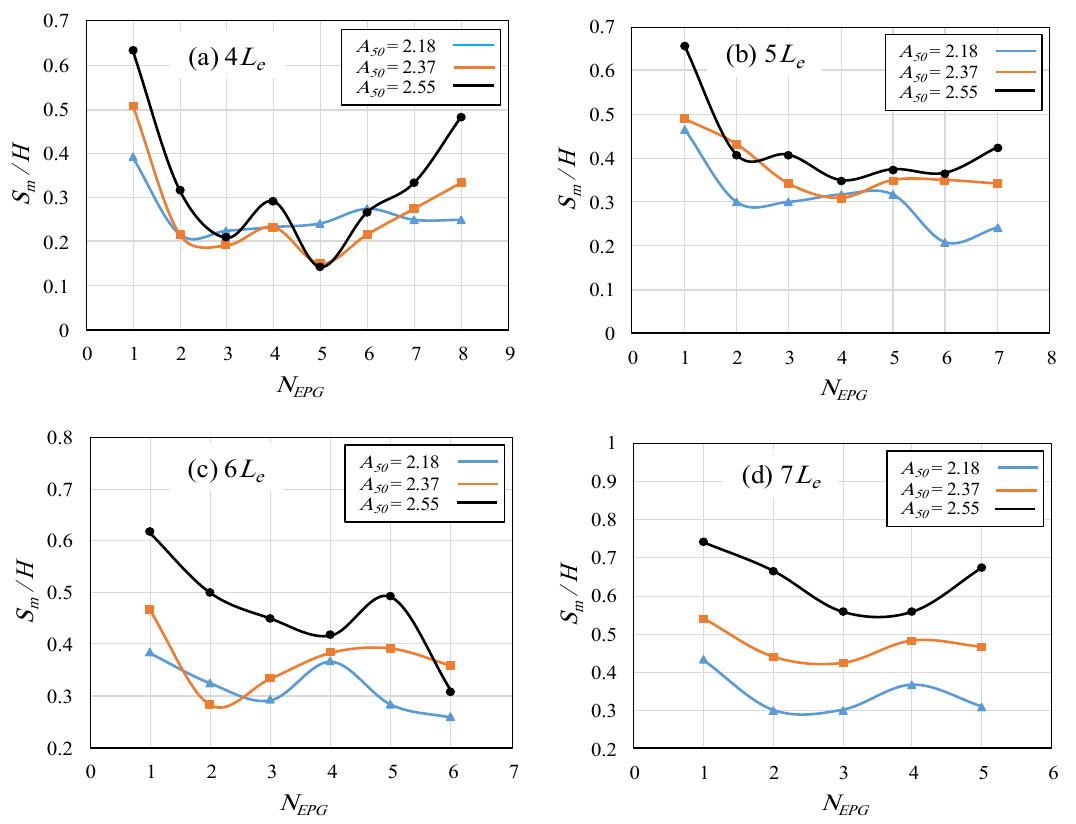
Figure 8. Relationship between the maximum scour depth occurred around the first enhanced permeable groin (EPG) and the maximum scour depth in the other EPGs at different distances and hydraulic conditions. ( a ) 4 L e , ( b ) 5 L e , ( c ) 6 L e , and ( d ) 7 L e .